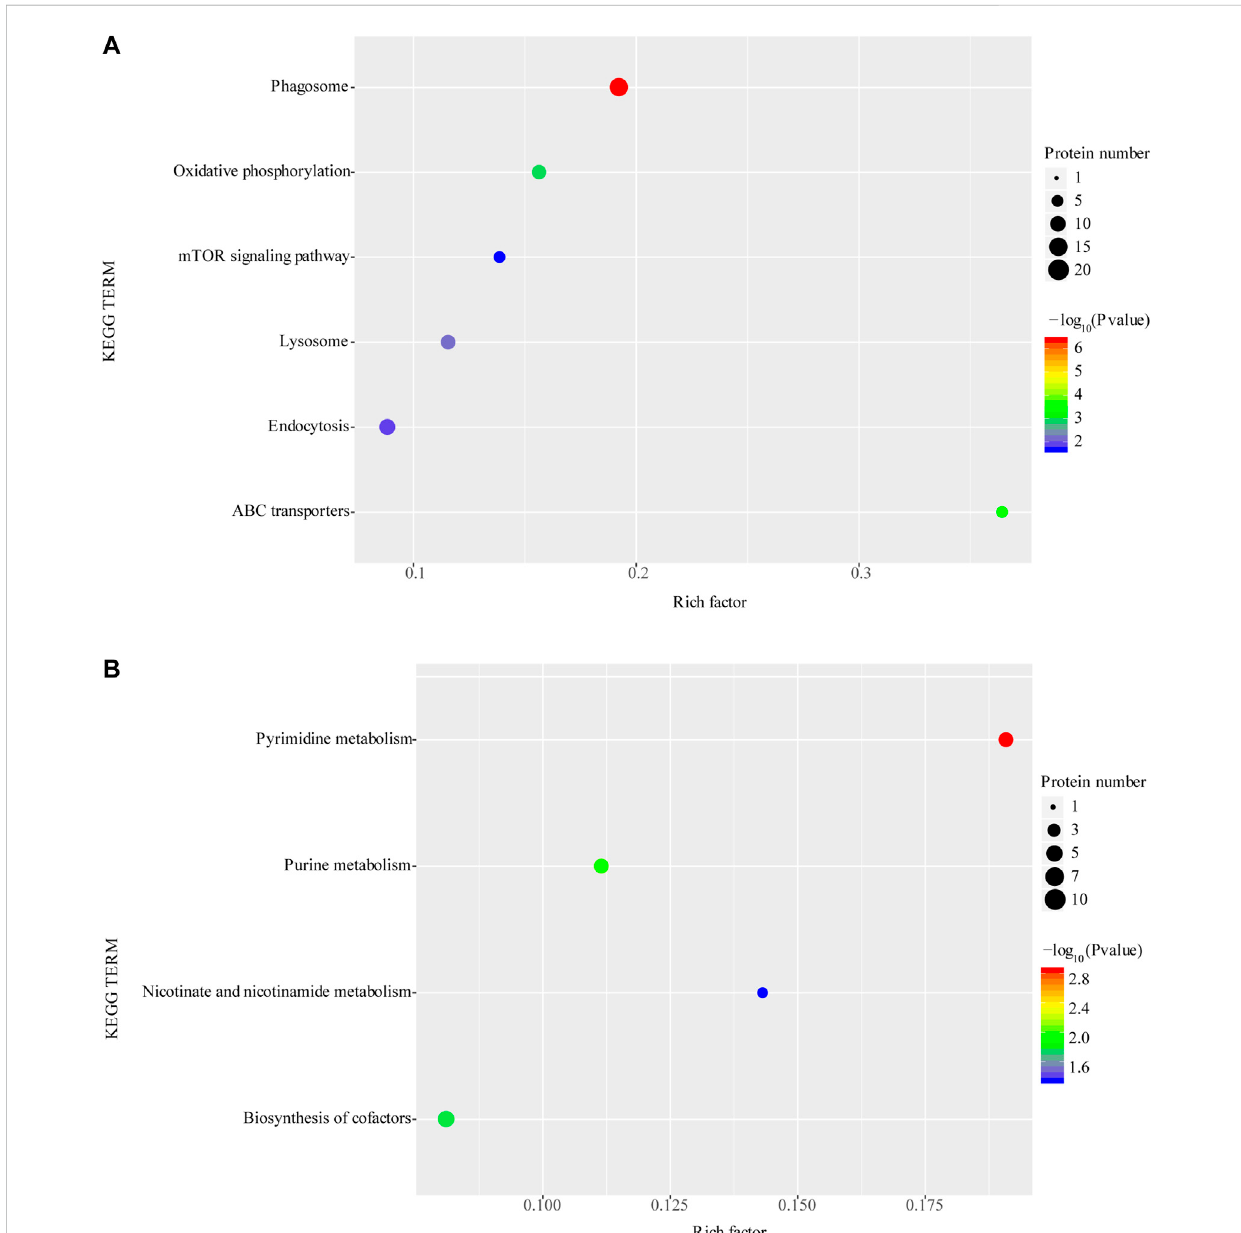
FIGURE 5 Enrichment of KEGG function of upregulated proteins (A) and downregulated proteins (B) . * p < 0.05 or ** p < 0.01 versus starvation group.